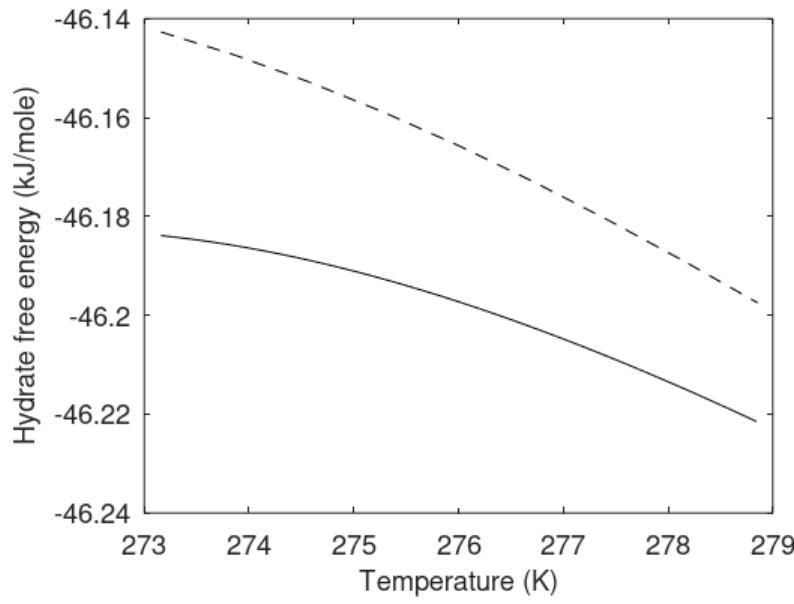
Figure 7. Free energy of hydrate formed heterogeneously from water and CH 4 gas (solid) and free energy of hydrate formed homogeneously from dissolved CH 4 in water (dashed).